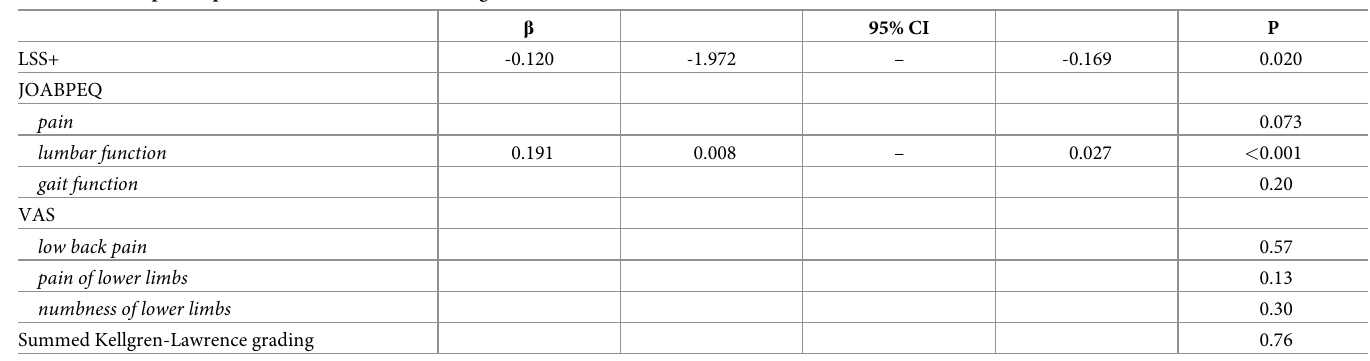
Table 4. The impact of parameters related to lumbar degenerative disease on